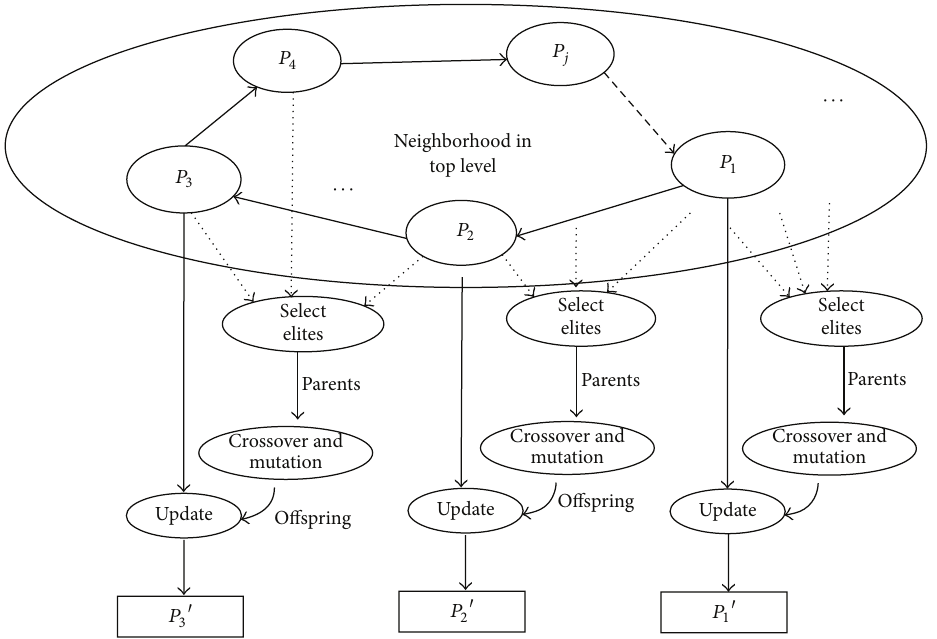
Figure 3: The information exchange mechanism based on crossover